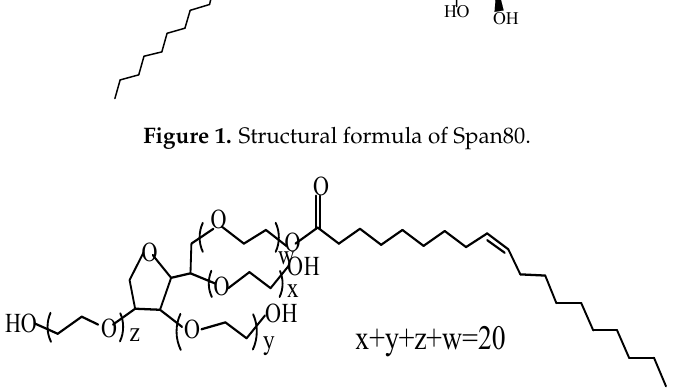
Figure 2. Structural formula of Tween80.